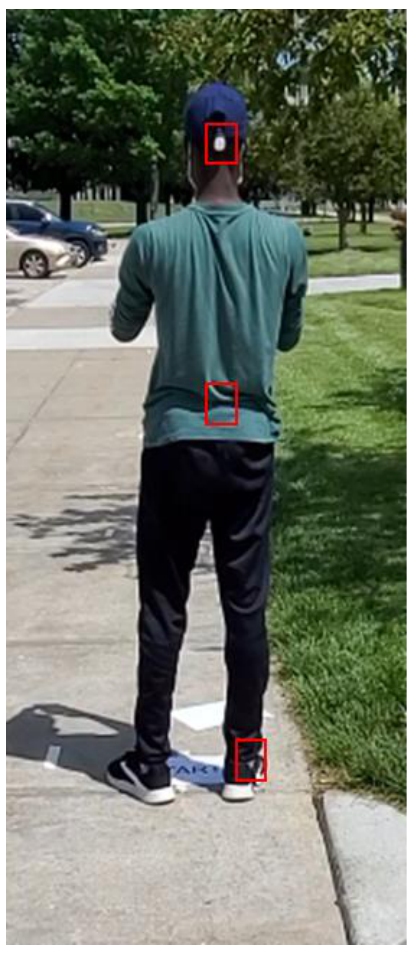
captured by sensors placed at the three different locations.